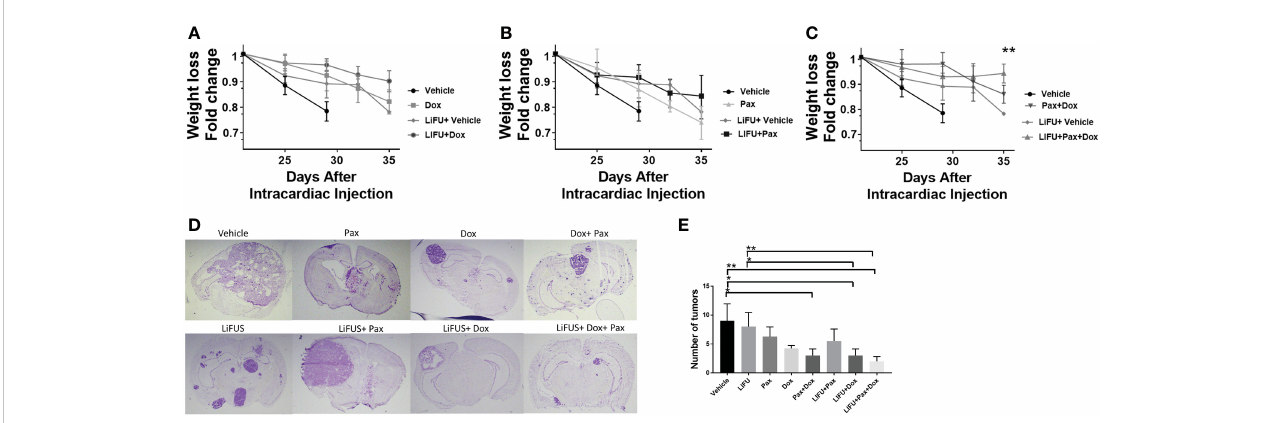
FIGURE 7 LIFU plus combinatorial chemotherapy therapy maintains weight in mice with metastatic MDA-MB-231Br tumors: (A-C) Weights loss for mice treated with LIFU+Dox-NP+Pax was signi fi cantly lower than the weight loss observed for vehicle or LIFU+vehicle. While LIFU+Pax, LIFU+ Dox-NP reduced weight loss compared to vehicle, the observed difference was non-signi fi cant. (D, E) Tumor count and imaging demonstrate LIFU+ combinatorial chemotherapy reduce number of brain metastases. * p<0.01, **